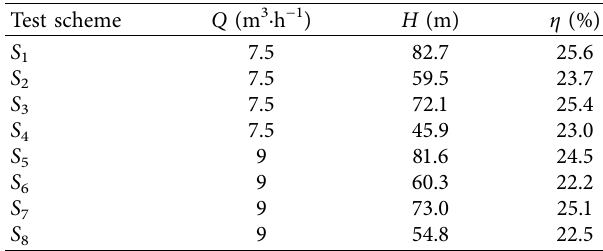
Figure 13: Performance curve. (a) Q - H curve. (b) Q - η curve. Table 3: Results of the highest efficiency point test.